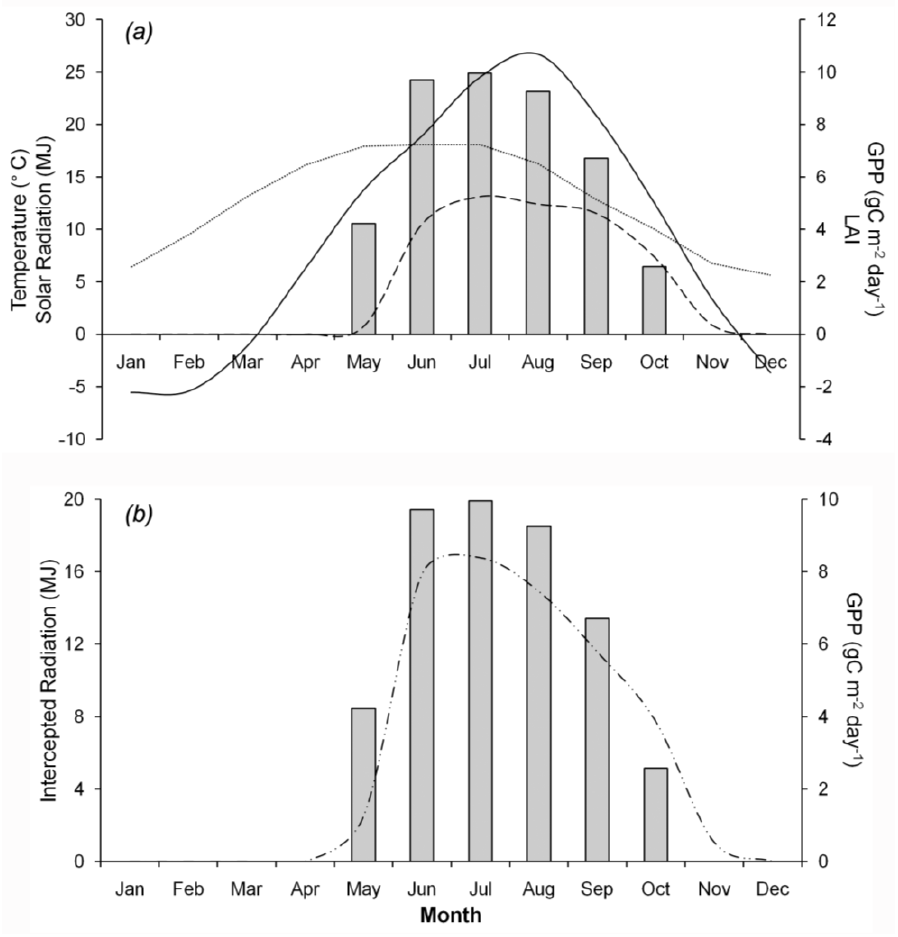
Figure 4. Comparison among (a) monthly gross primary productivity (solid bar) with mean monthly temperature (solid line), monthly solar radiation (small dashed line) and monthly LAI (big dashed line); (b) monthly gross primary productivity (solid bar) with monthly intercepted radiation (dashed